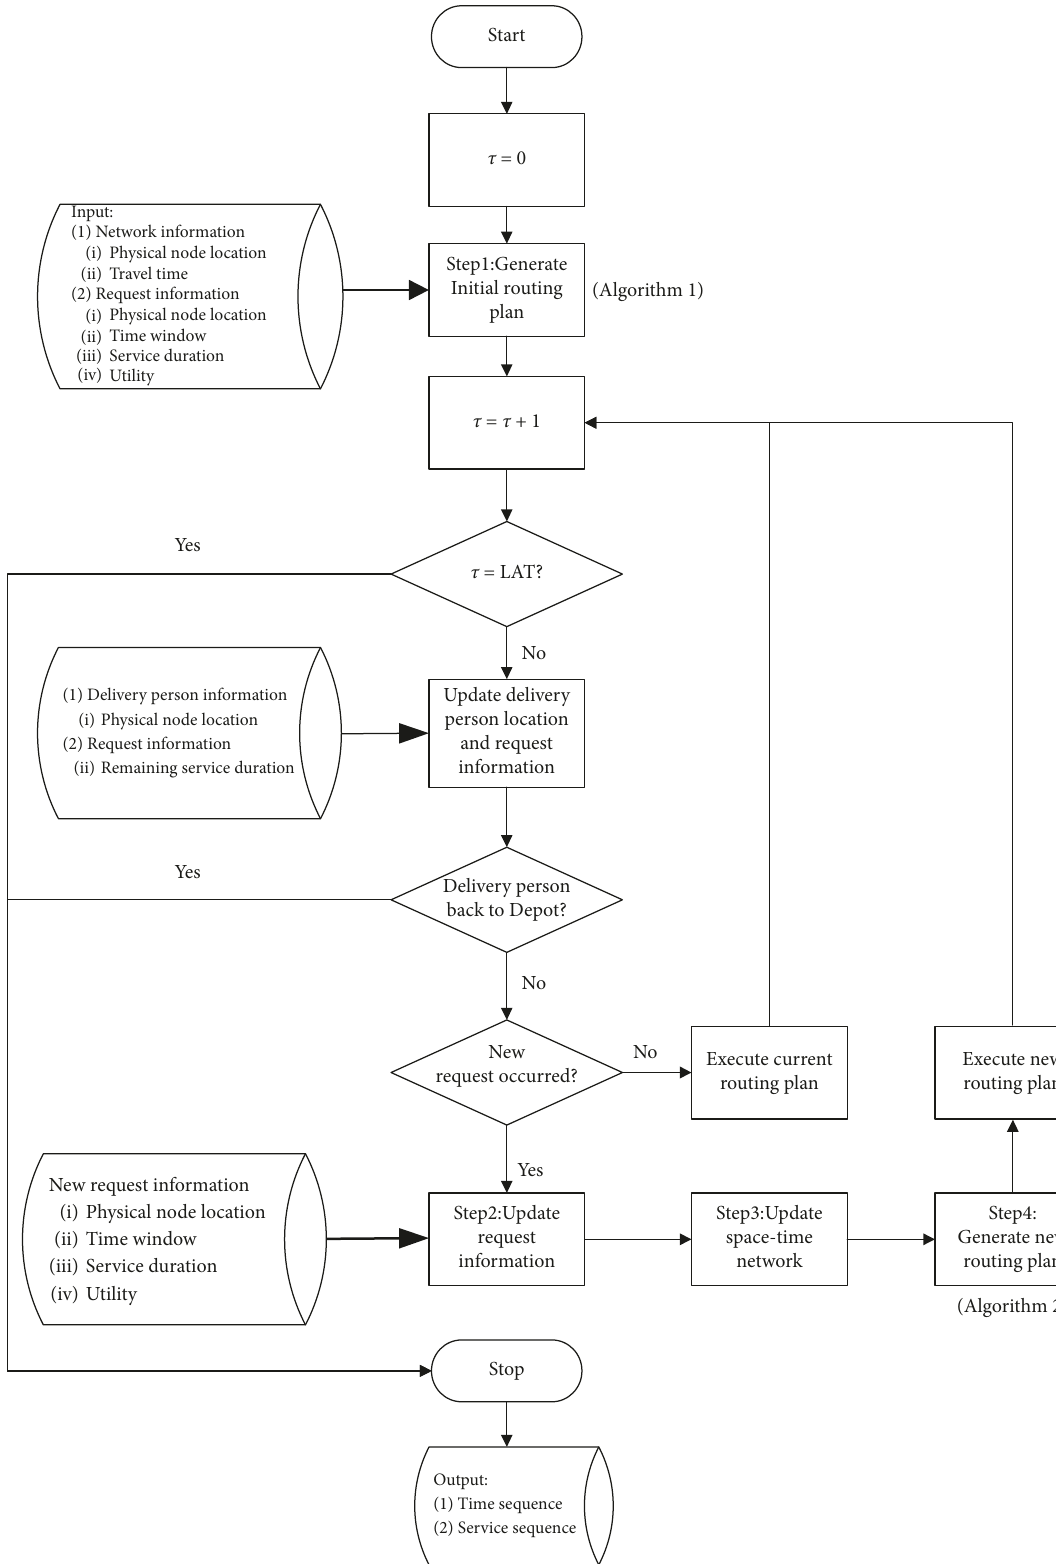
Figure 6: Flowchart of the overall solution